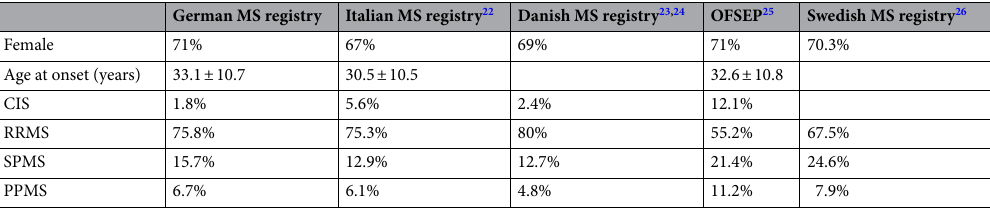
Table 4. Comparison of patient characteristics. Patients with unknown disease course are excluded. CIS clinically isolated syndrome, MS multiple sclerosis, OFSEP observatoire français de la sclérose en